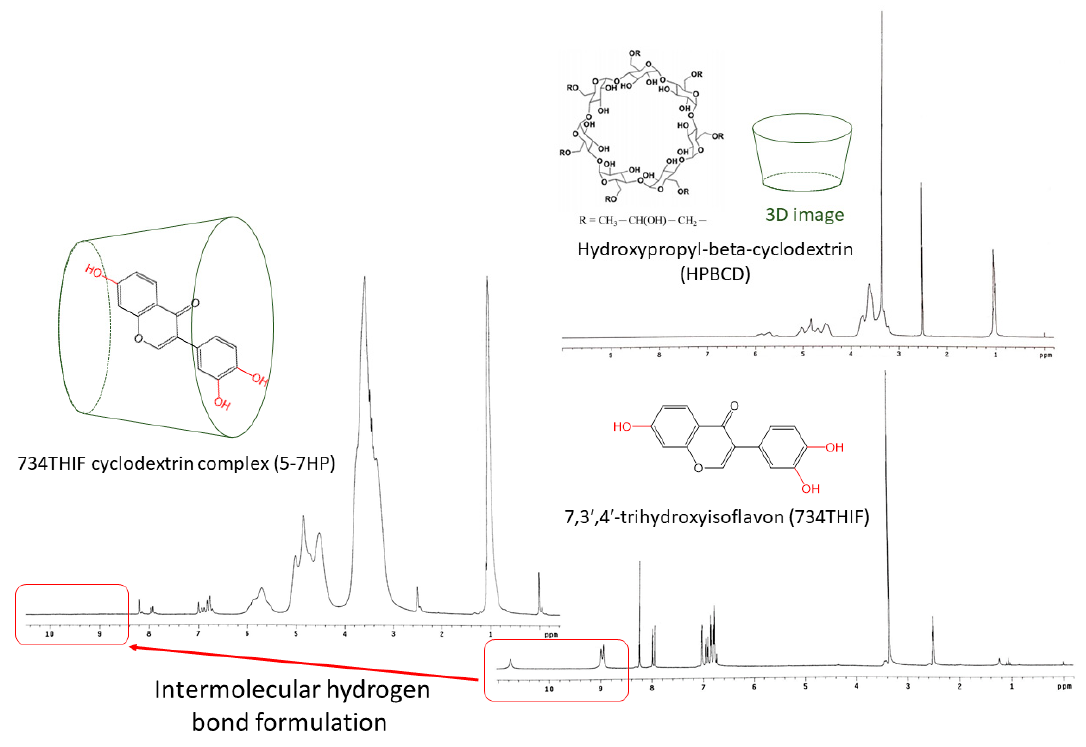
Figure 5. 1 H-NMR spectra and chemical structural formula of 734THIF, HPBCD, and 5-7HP.